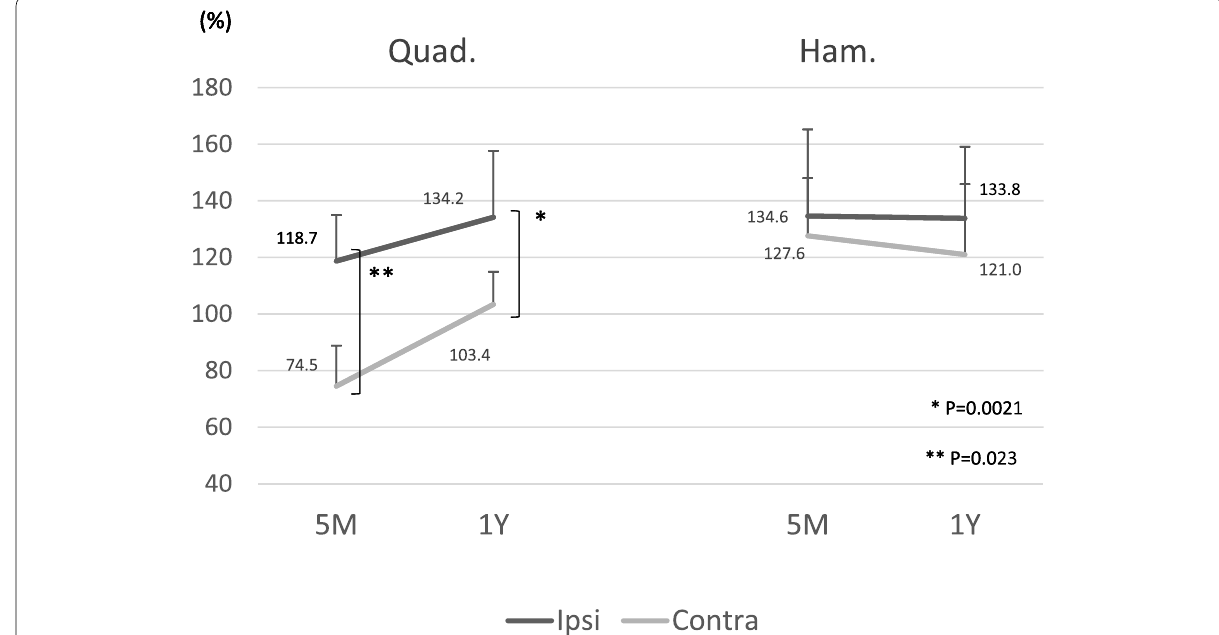
Fig. 3 Muscle strength recovery of the non-reconstructed knees in relation to the preoperative normal knees was investigated. Quadriceps muscle strength was significantly weaker in the C-BTB group at 5 months after surgery (Quad.: 74.5 p 0.0021, Ham.: 127.6 20.4% in the C-BTB vs. 134.6 = ± 12 months (Quad.: 103.4 11.5% in the C-BTB vs. 134.2 ± I-BTB; p =